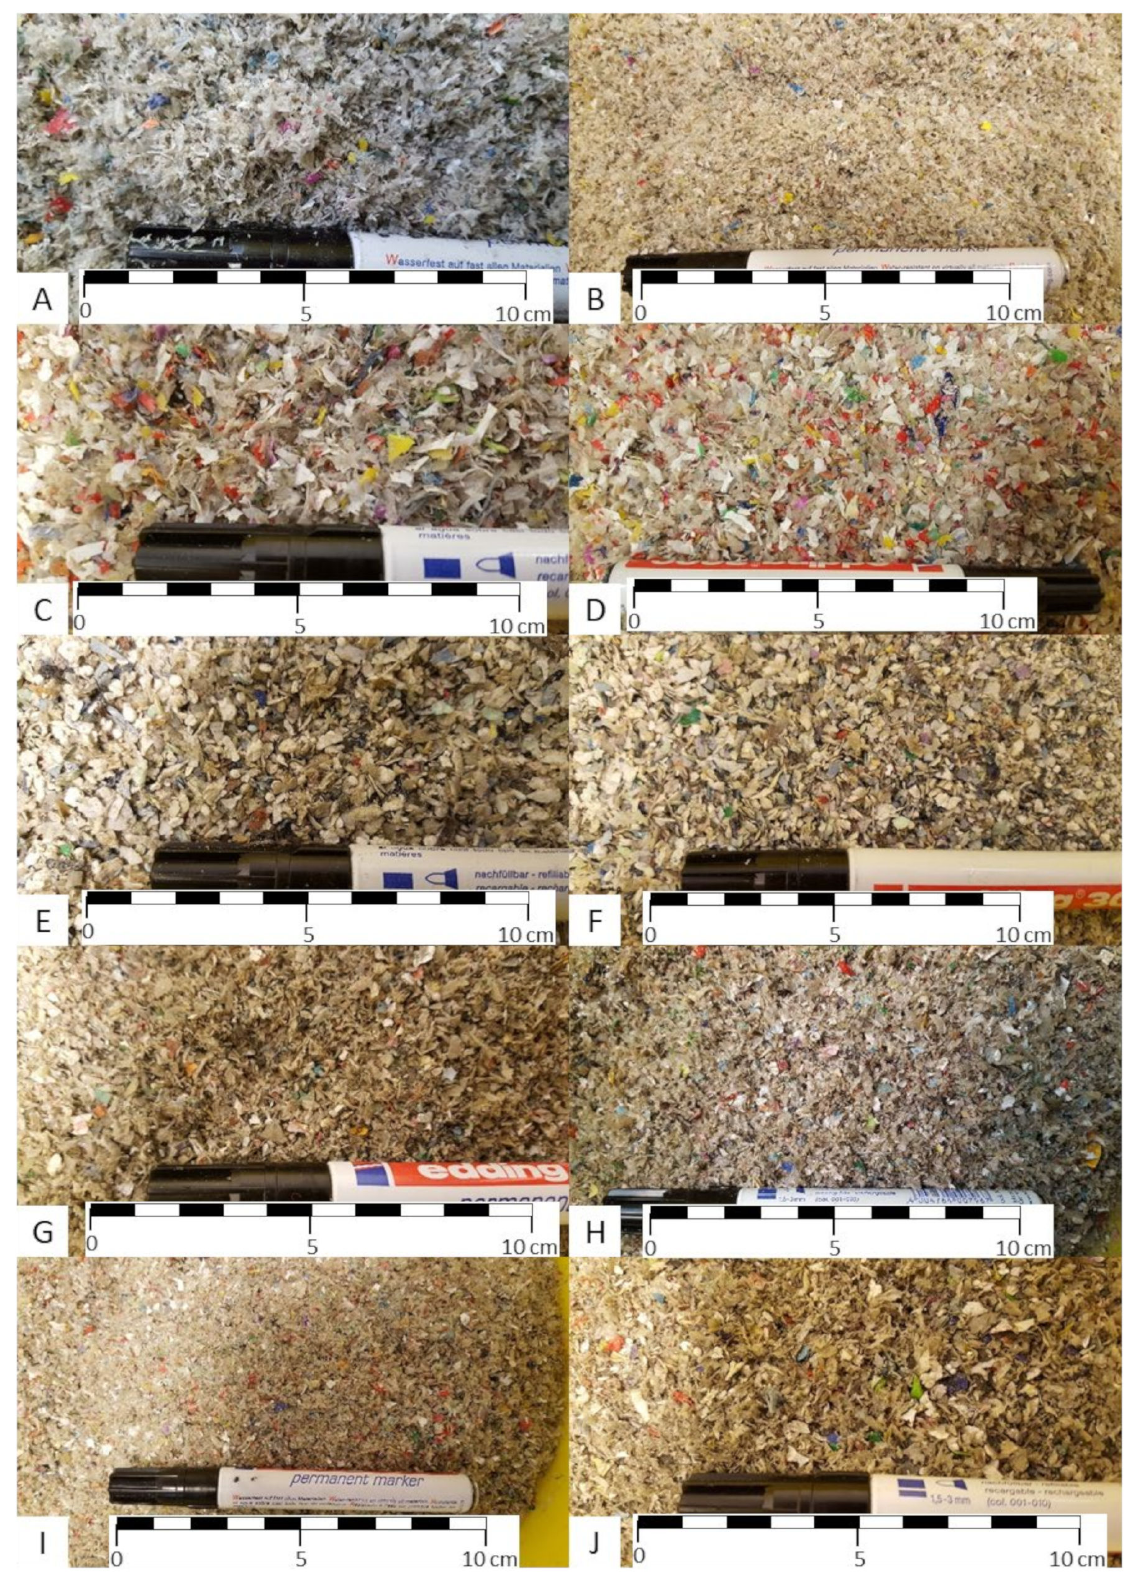
Figure A5. Exemplary photos of the flakes of all investigated materials after shredding to <4 mm: P_PE— A ; P_W,PE— B ; P_PP— C ; P_W,PP— D ; P_PS— E ; P_W,PS— F ; PO_A— G ; PO_W, A–H ; PO_B— I ; and P— J